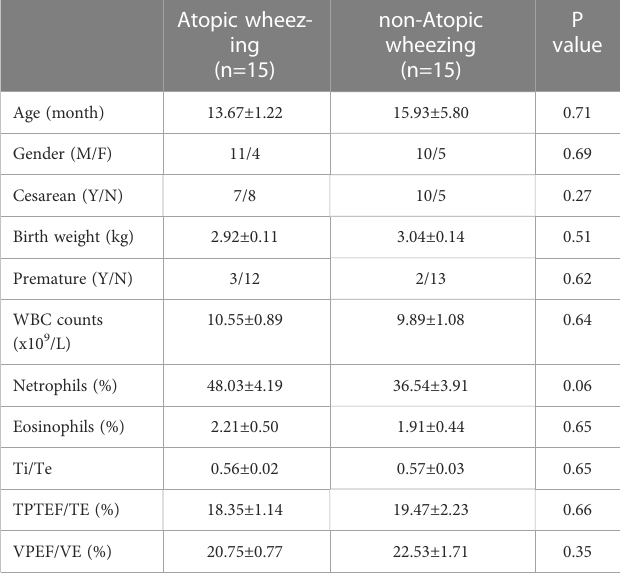
TABLE 2 Clinical characteristics of recurrent wheezing infants with and without atopy. Atopic wheez- ing